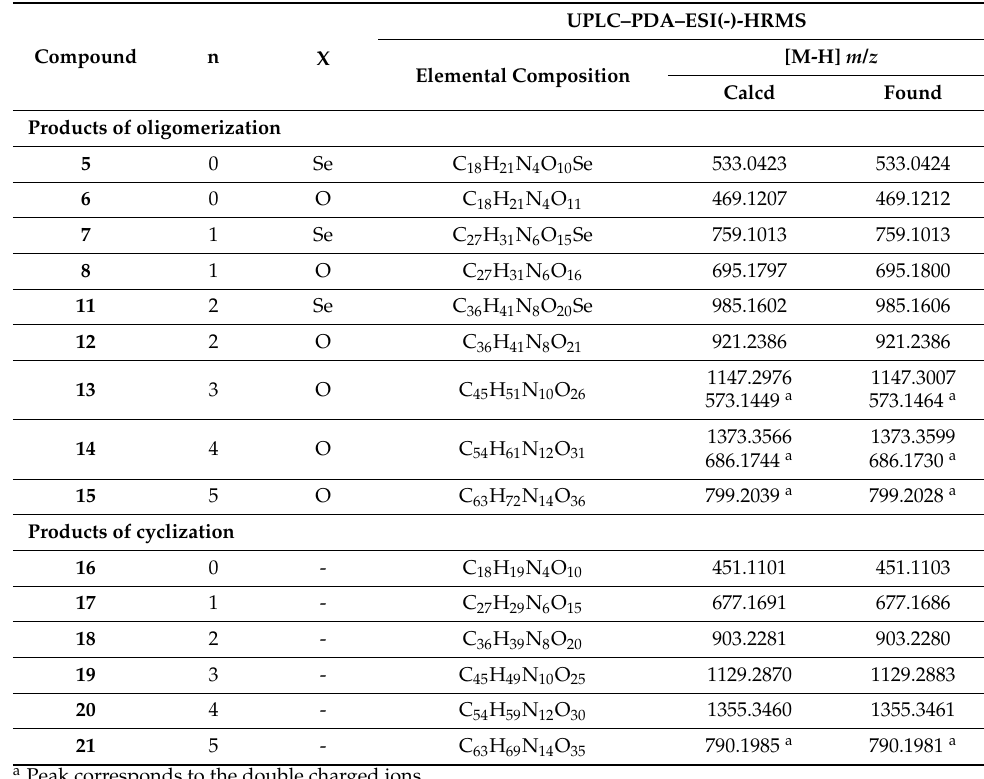
Table 4. UPLC–HRMS identification products of cyclization/oligomerization.